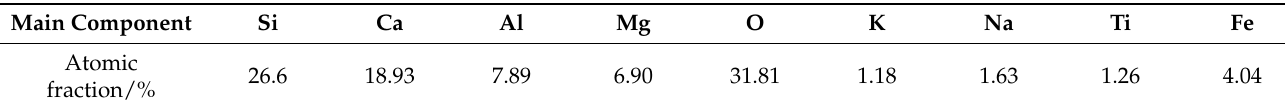
Table 2. Basic properties of the basalt fibers.